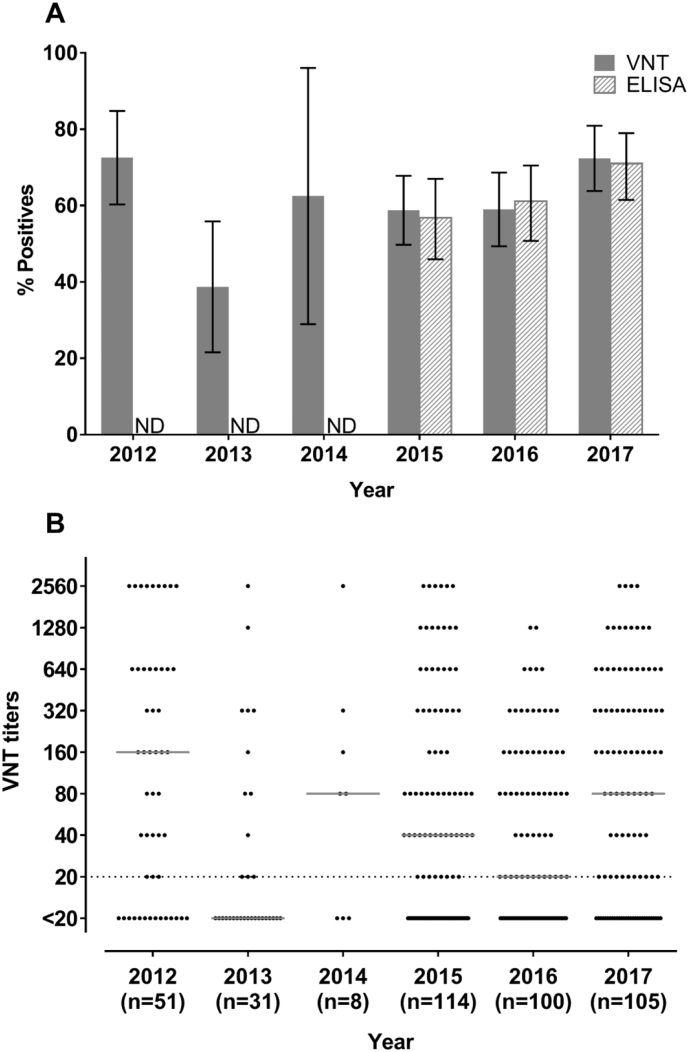
Detection of MERS-CoV antibodies in sera of dromedary camels, Israel 2012–2017. A) Percentage of MERS-CoV antibody positive by VNT and ELISA. Point estimate proportions (PEP) and confidence intervals (CI) are given per year. B) Serum neutralizing antibody titers by VNT. Red line indicated median; dotted black lines at 20 indicates cutoff for the VNT assay. (For interpretation of the references to colour in this figure legend, the reader is referred to the web version of this article.)